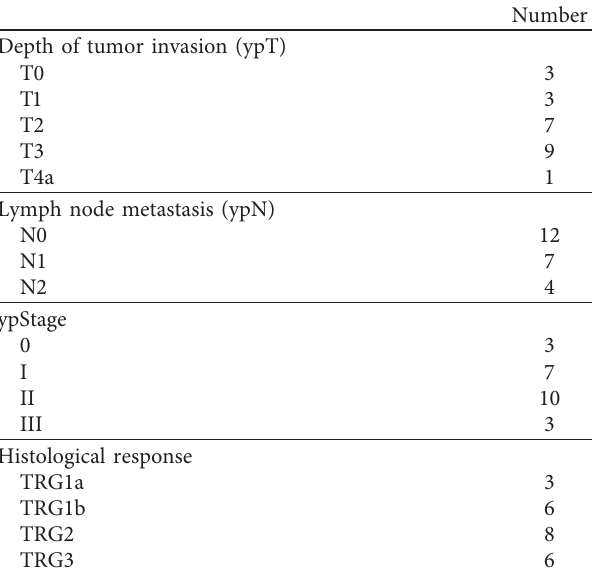
Table 5: Pathological findings ( n �